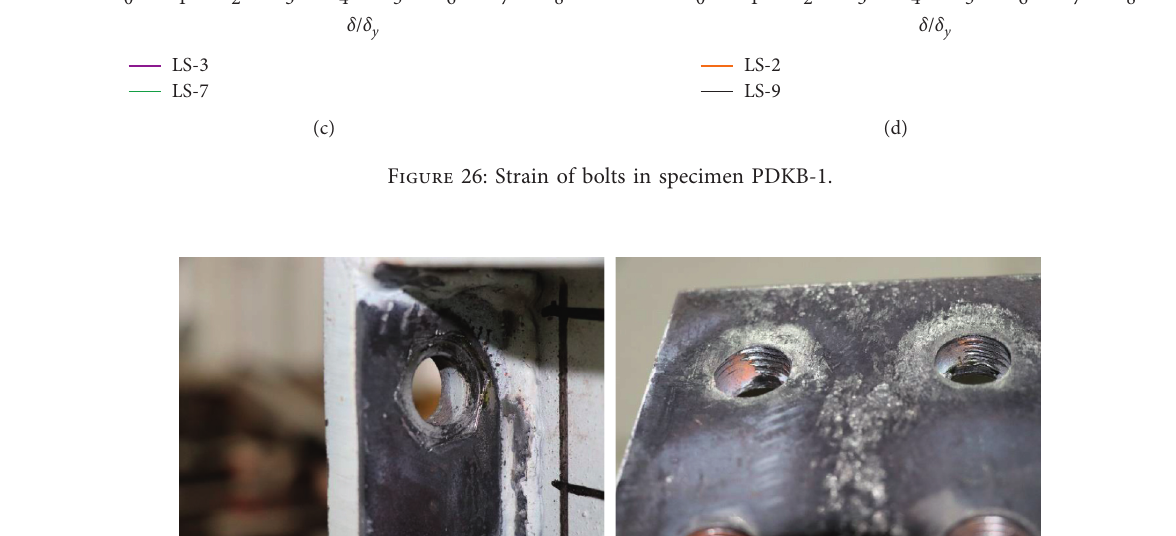
Figure 27: Deformation at bolts